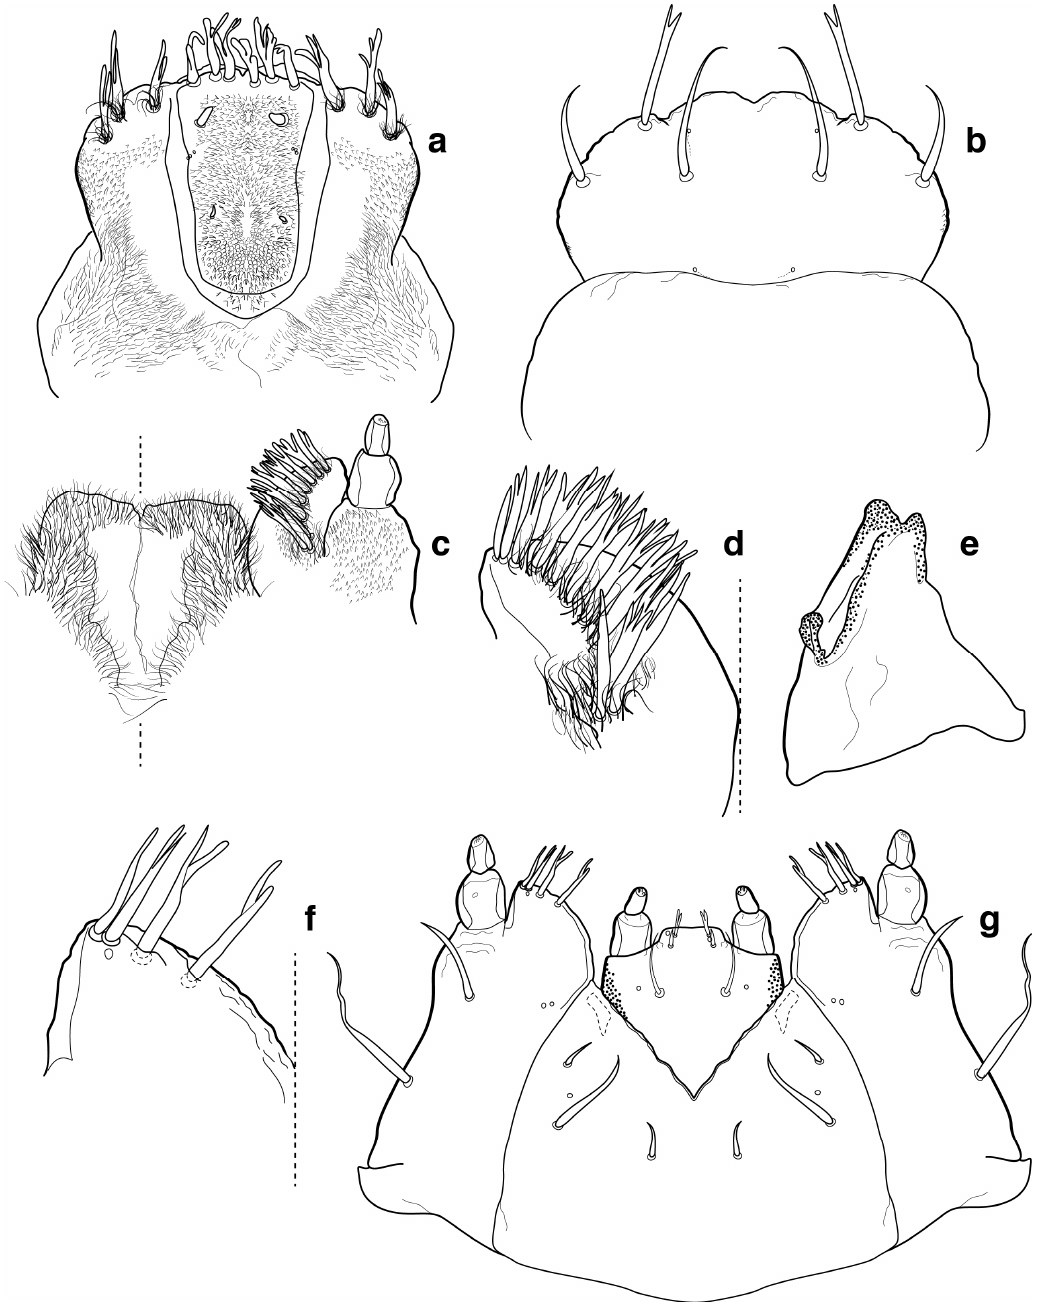
Figure 71. Odoiporus longicollis mouthparts: ( a ) epipharynx; ( b ) clypeus (incomplete) and labrum; ( c ) detail of hypopharynx, mala, and maxillary palp, dorsal view; ( d ) detail of mala and dorsal malar setae; ( e ) mandible; ( f ) detail of mala and ventral malar setae; and ( g ) labio-maxillary complex, ventral view.